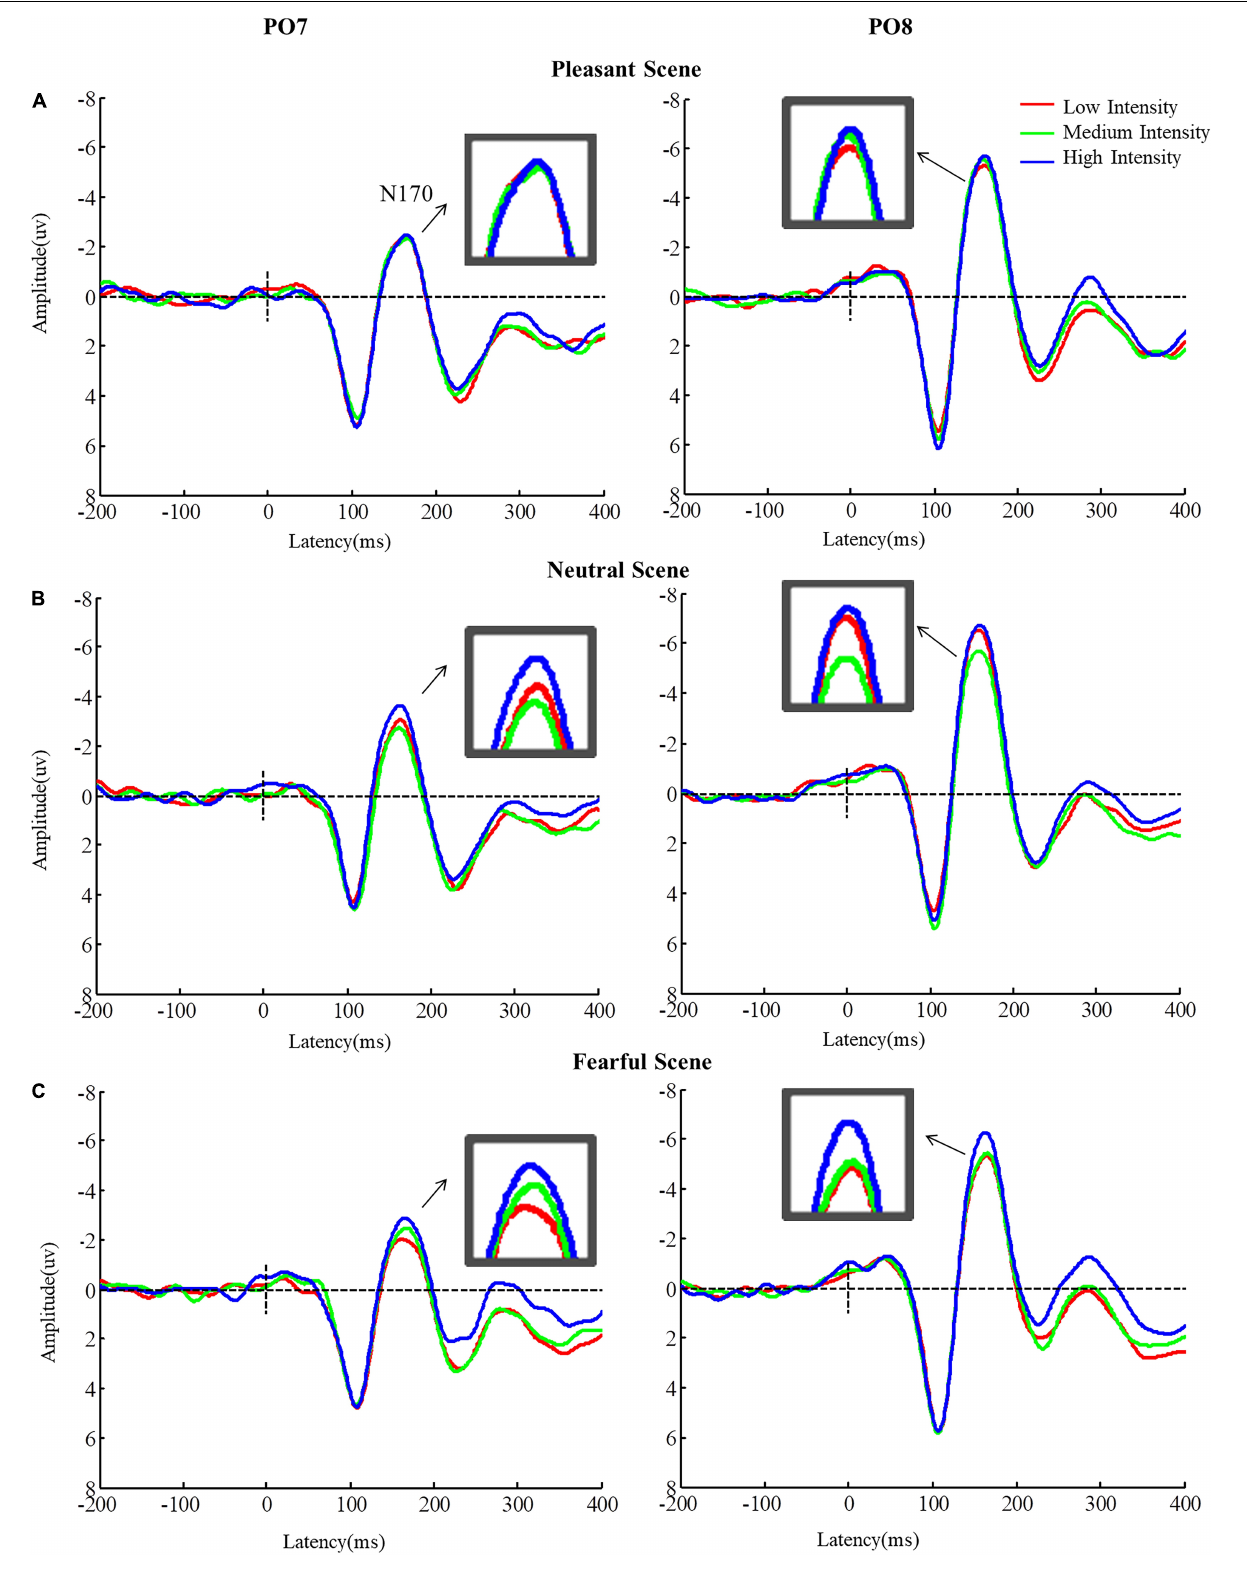
FIGURE 5 | Grand Average N170 amplitudes for (A) low intensity, (B) medium intensity, and (C) high intensity fearful facial expressions in different emotional scenes.